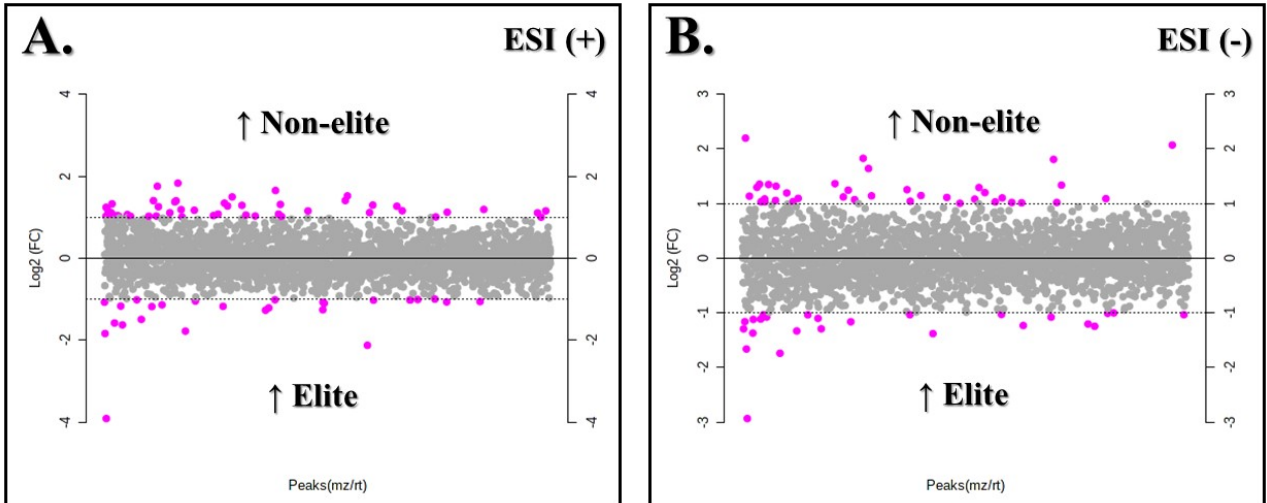
Figure 2. Comparison of the physiological profiles of soccer players from both elite and non-elite teams for the ESI (+) ( A ) and ESI ( − ) modes ( B ) by fold-change analysis with threshold 2. The pink circles represent different features between the teams. The upper pink circles represent features above the threshold with greater relative abundance for the non-elite team, while the lower pink circles represent features above the threshold with greater relative abundance for the elite team.